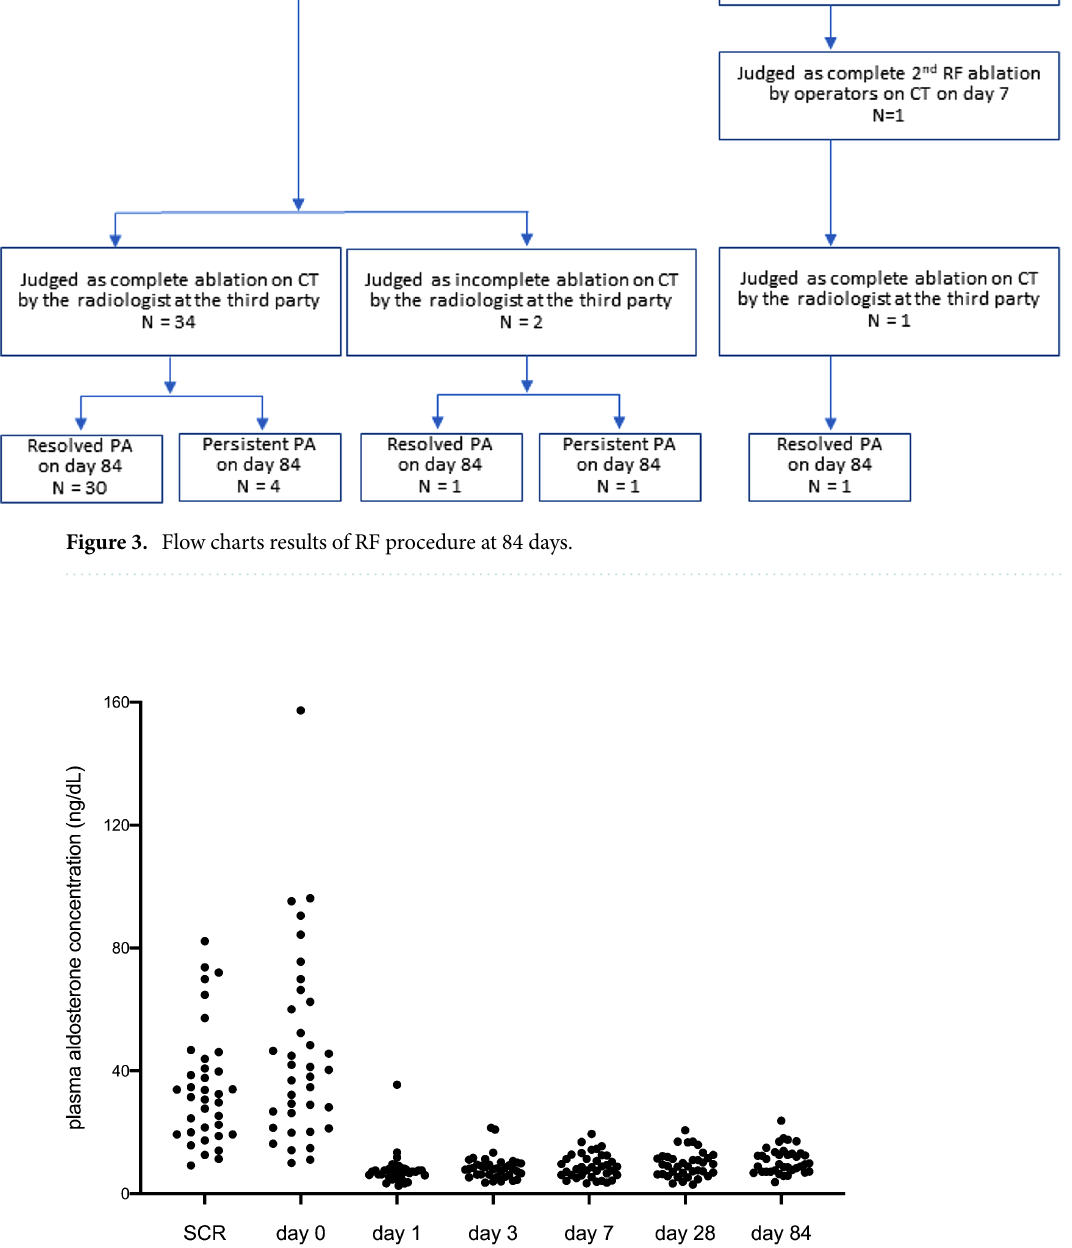
Figure 4. The results of transition of aldosterone concentration from day0 to 84 day after RF procedure. SCR: Day of screening for primary